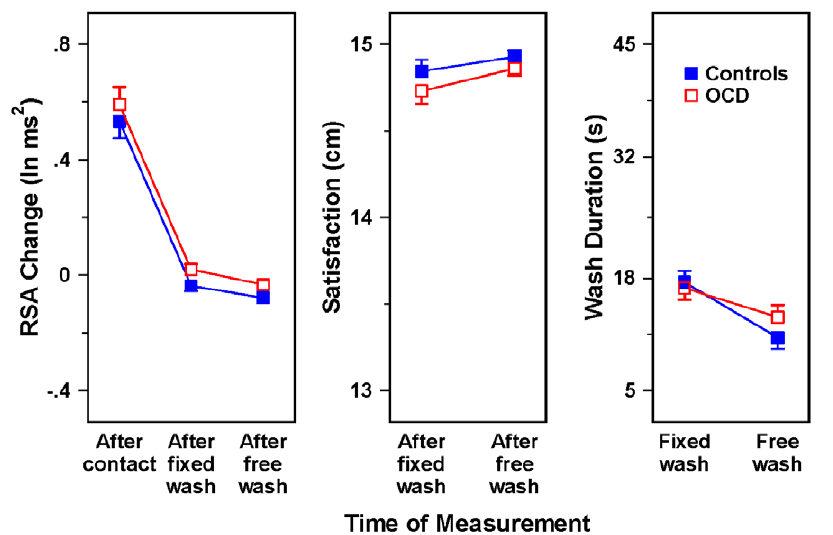
Figure 3. Effect of hand washing on RSA change, satisfaction, and wash duration in OCD patients with checking compulsions vs. non-patient controls. Note: Error bars represent 1 SE.